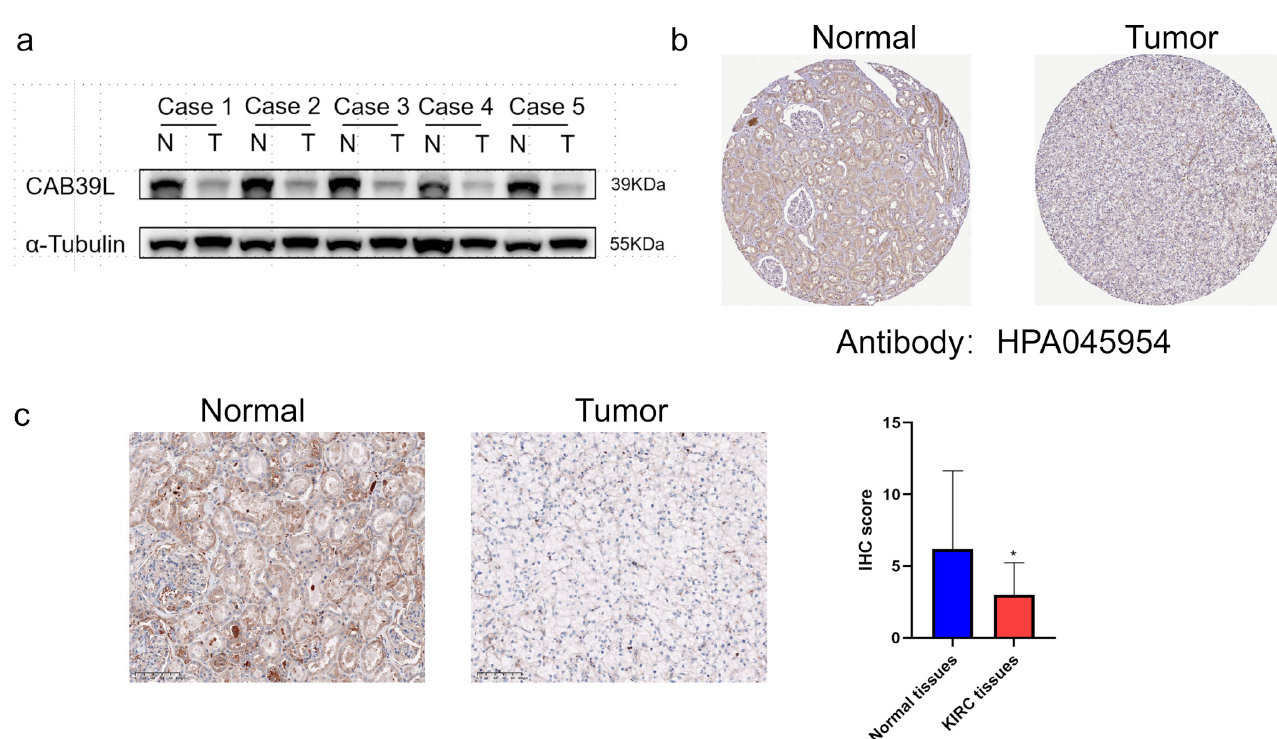
Figure 9. The protein level of CAB39L in paired KIRC samples. ( a ) Western blot detection of CAB39L expression in five paired KIRC samples. ( b ) IHC staining outcomes of CAB39L in KIRC and adjacent non-tumor tissues (HPA). ( c ) IHC staining outcomes of CAB39L in KIRC and adjacent non-tumor tissues (clinical paired KIRC tissues). * p < 0.05.